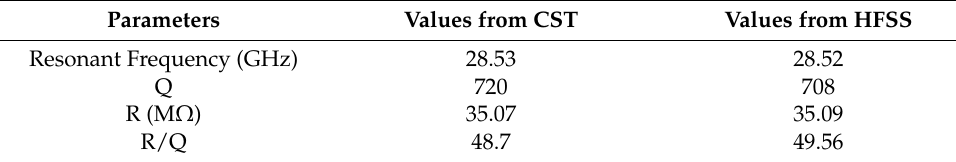
Table 3. Comparison of the simulated cavity parameters (intermediate cavity).